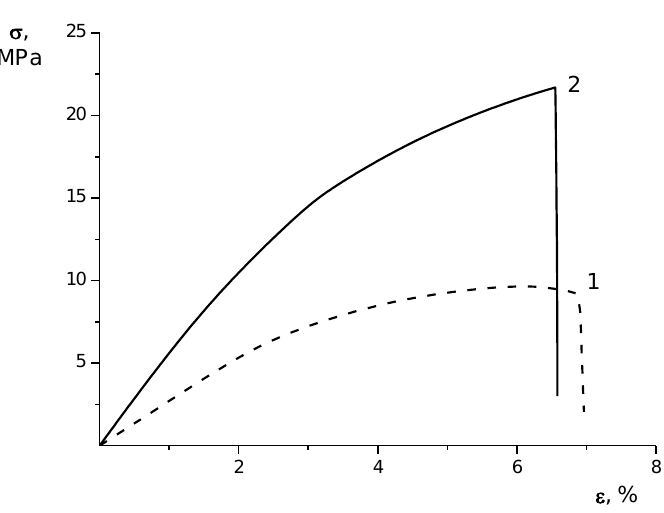
Figure 3. Stress-strain curves of the CS (1) and CS–HA (2) nonwoven materials.